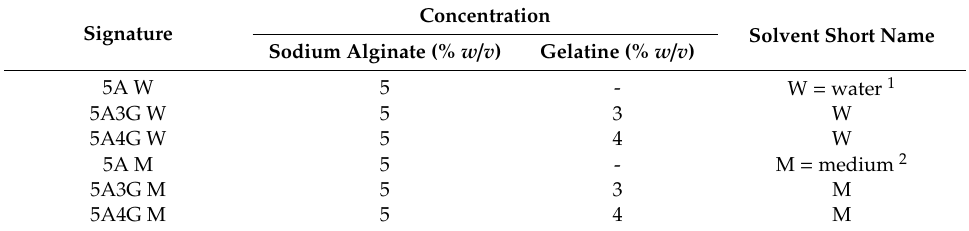
Table 1. Applied signatures of the tested materials, the concentration of sodium alginate and gelatine and kind of applied